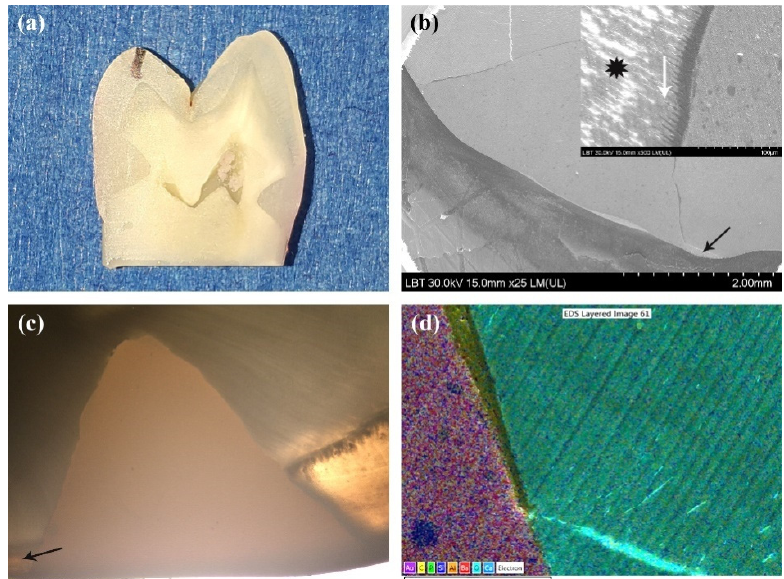
Figure 6. Dynamic Flow ® restorations. Good adhesion ( a ). Intact adhesive interface of the enam- el-located restoration on SEM image (20×). Inset, perfect visible 20 µ m long rete tags (500×) ( b ). Optical microscopy of restoration b ( c ). Cracked cervical enamel on EDX image not interfering with the adhesive layer (500×) ( d ). black arrow = cervical enamel; white arrow = resin tags; asterisk = dentin tubuli.